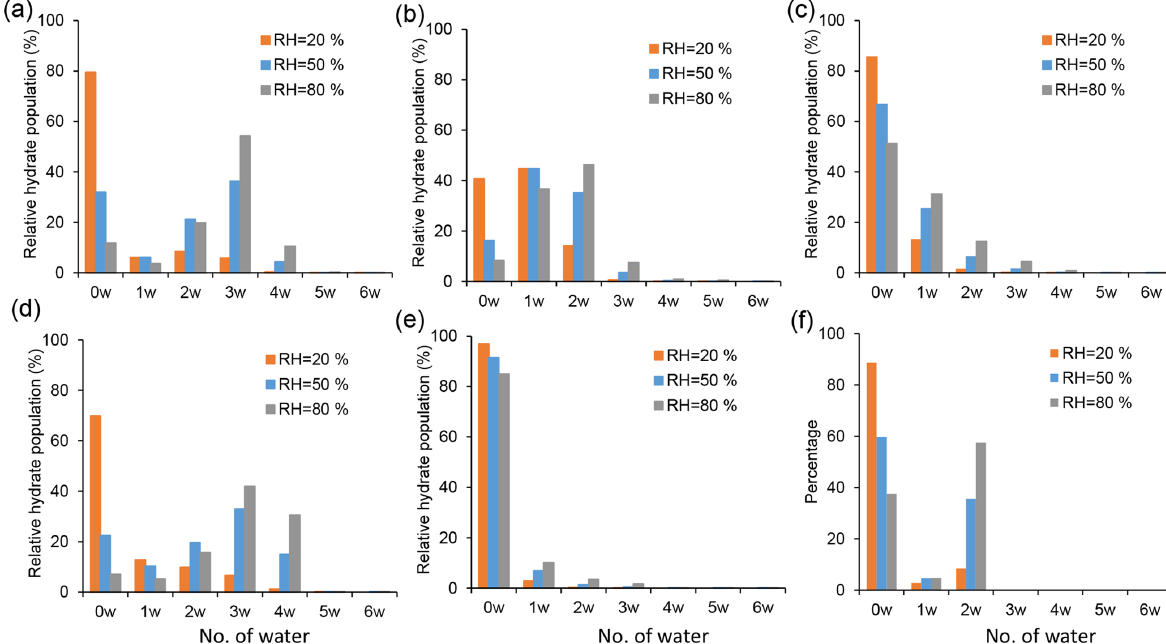
Figure 7. Hydrate distributions of clusters under different RH levels (20%, 50%, and 80%). Panels (a) , (b) , and (c) show clusters for (cid:113) (cid:113) (cid:113) (cid:113) SA AM, SA DMA, and SA DMA AM, respectively. Panels (d) , (e) , and (f) show clusters with one SUA addition on the basis of (a) , (b) , and (c) clusters. In all RH cases, T = 298K.